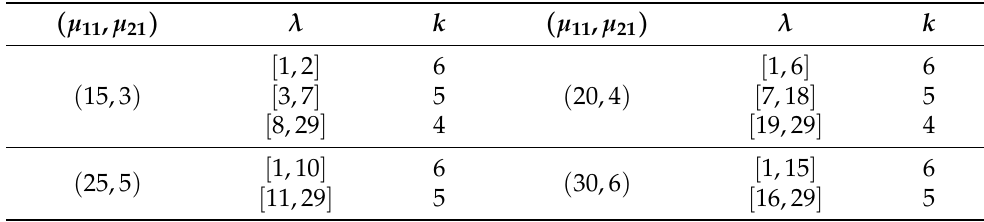
Table 3. Optimal policy k versus λ , µ 11 and µ 21 for fixed µ 12 = 10, µ 22 =